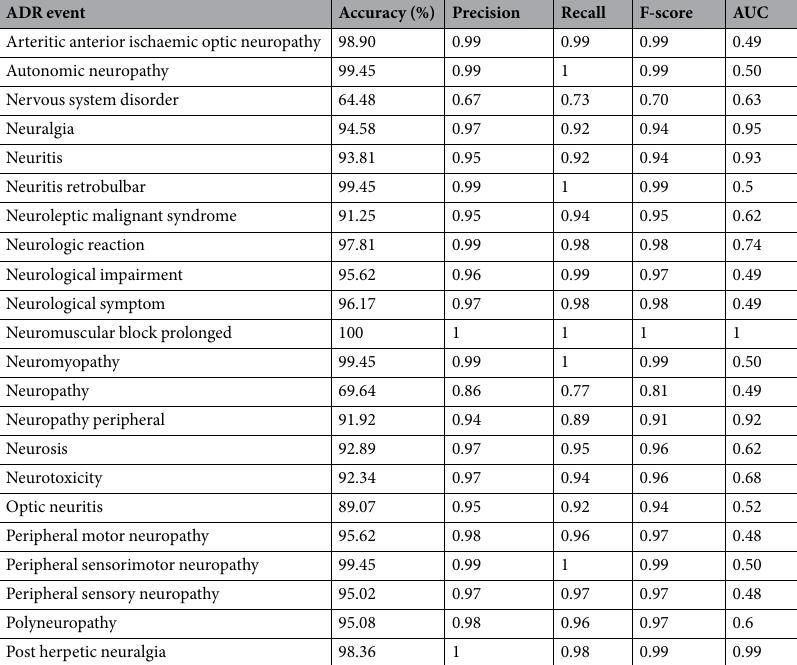
Table 4. Provides the performances of the models generated using the chemical